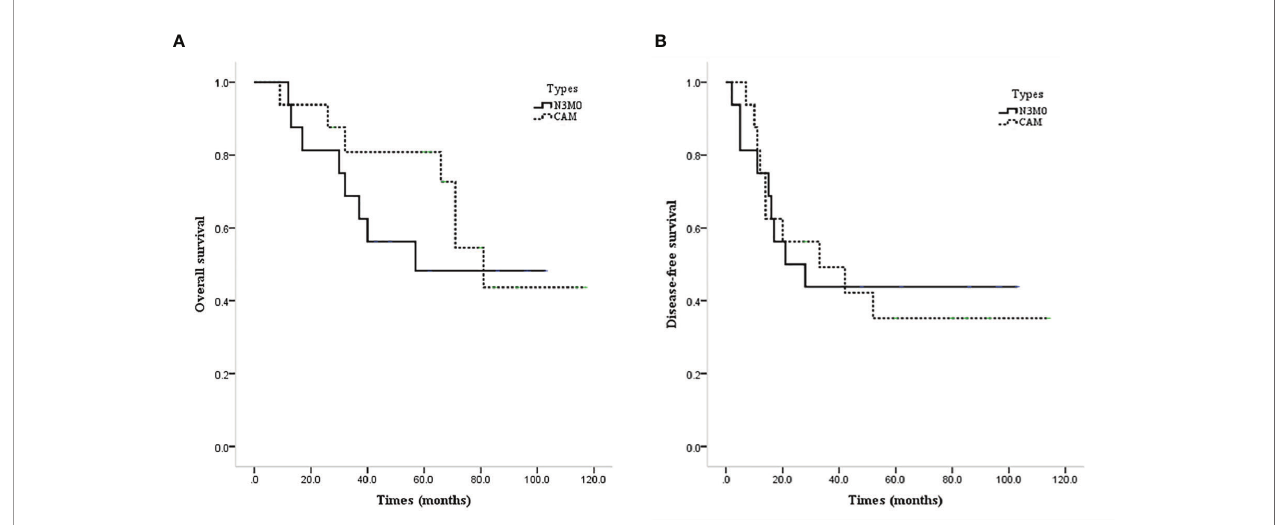
FIGURE 5 | Survival curves of CAM and N3M0 patients. (A) OS of CAM and N3M0 patients. (B) DFS of CAM and N3M0